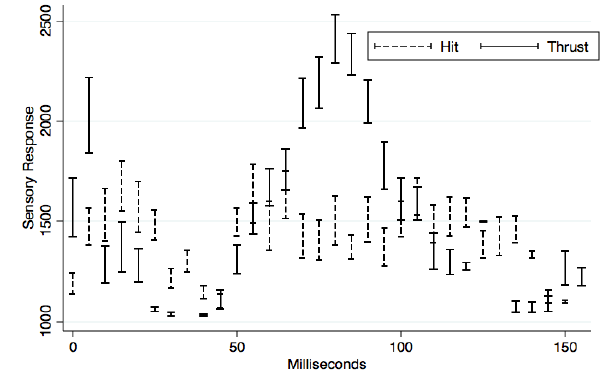
Figure 5. Mean and confidence interval of the time series of readings (y-axis) provoked by hit (superficial strikes, dashed lines) and thrust (strikes displacing the surface, unbroken lines)